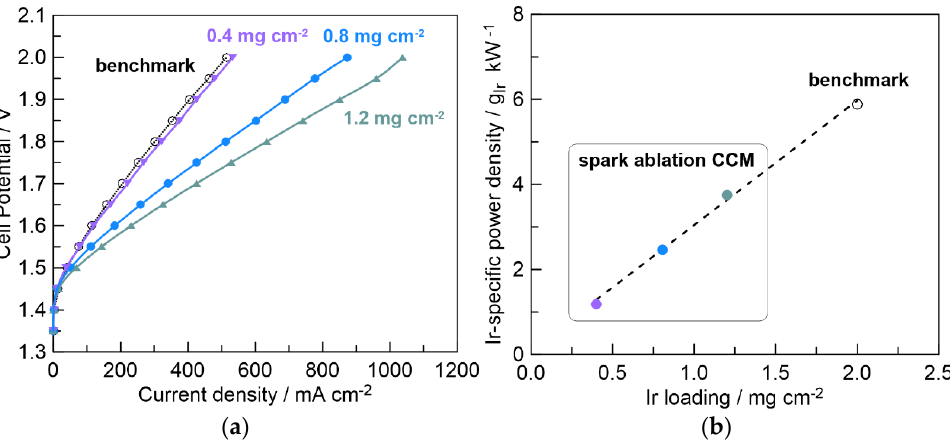
Figure 2. ( a ) Polarization curves at 60 °C obtained with various Ir loadings at the spark-ablation anode-coated CCMs and the commercial CCM (benchmark, 2 mg IrRuO x cm −2 ). In all cases, Pt-carbon cloth cathodes (4 mg cm −2 ) were mechanically attached to the opposite side of the Nafion membranes. ( b ) Ir-specific power density (calculated at 200 mA cm −2 ) as function of Ir content for benchmark and spark-ablation CCMs.